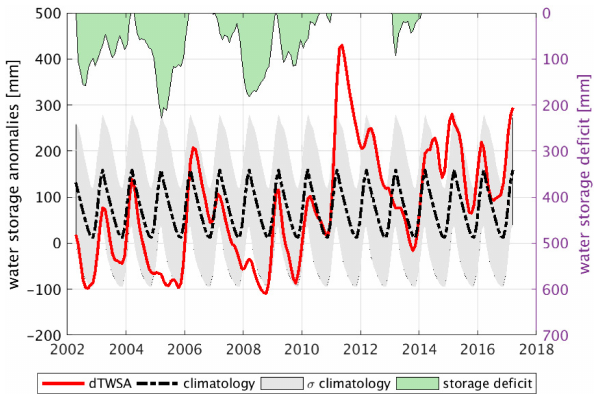
Figure 1. Water storage deficit from GRACE. The smoothed and detrended TWSA (dTWSA – red plot) is reduced by its climatology (black plot) to estimate the deviation from the climatology. The neg- ative residuals from the climatology are plotted on the upper axis as a green shaded area and scaled on the right side. The gray shading indicates ± 1SD (standard deviation) of the